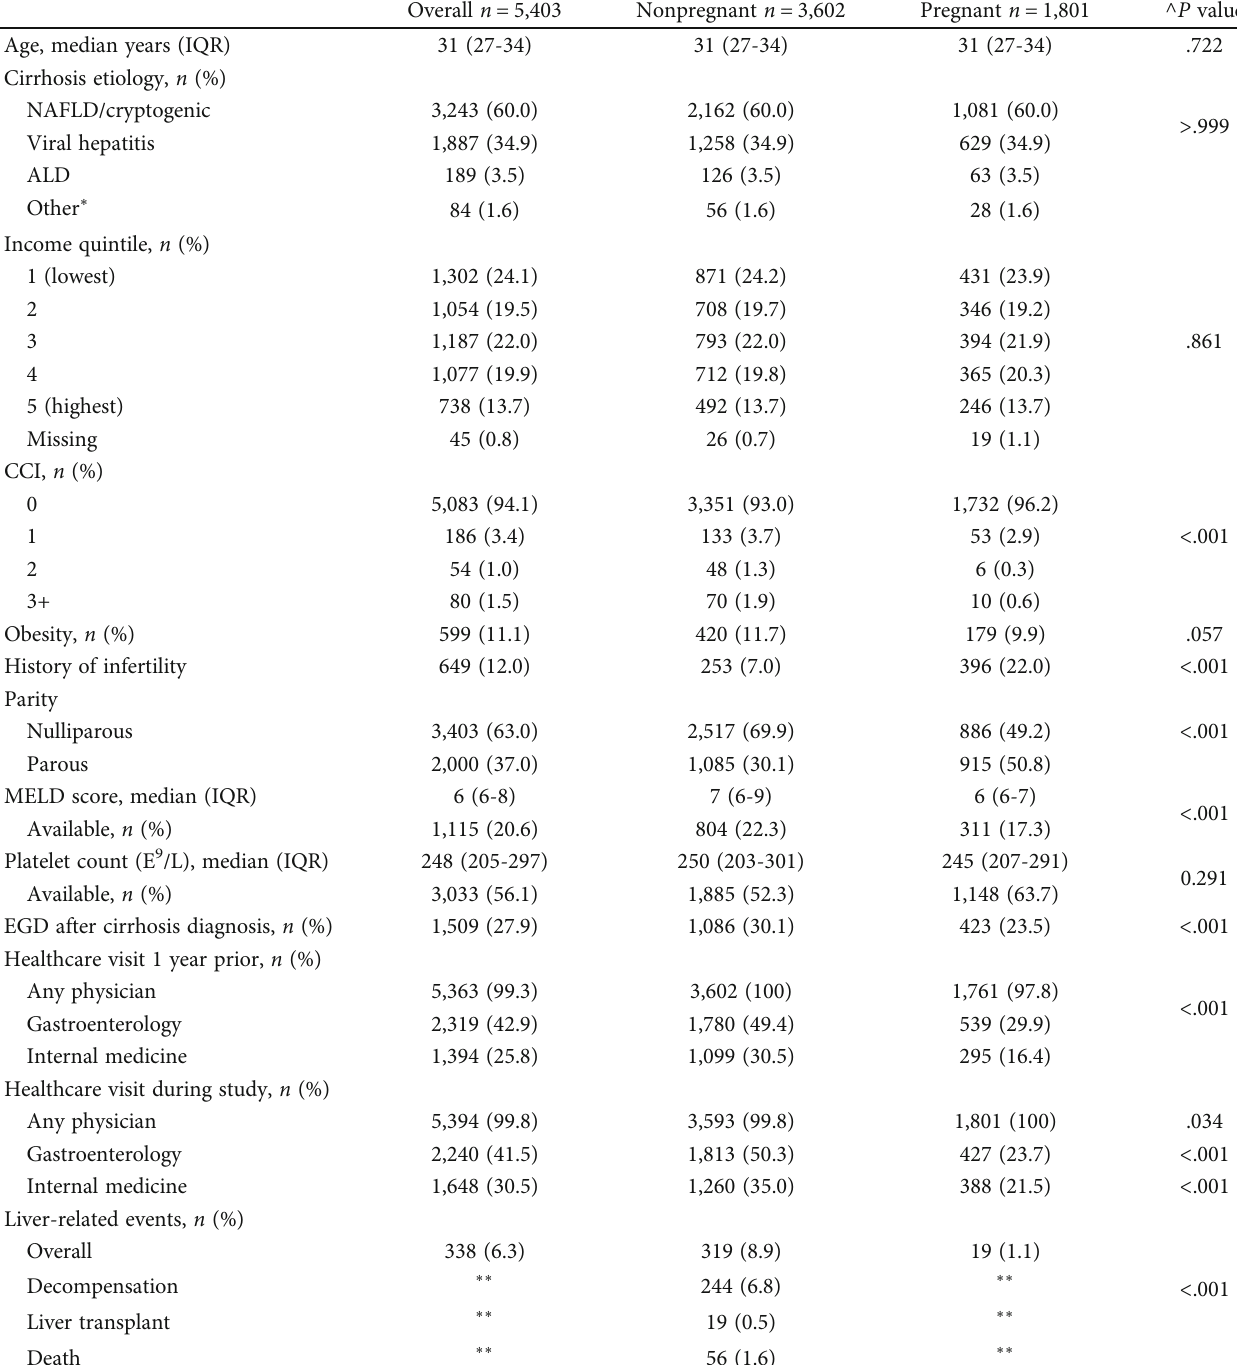
Table 1: Baseline demographics of the matched cohort of women with cirrhosis strati fi ed by pregnancy